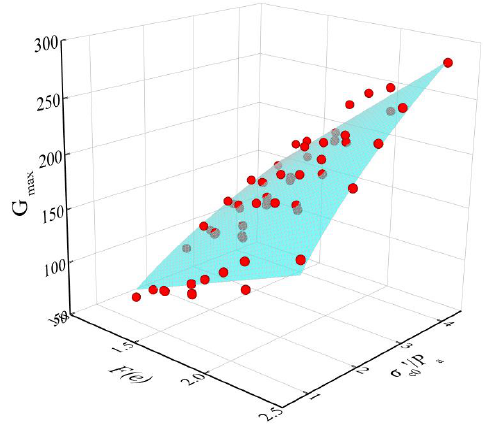
Figure Figure 8. The modified Hardin model for Nantong marine silty sand with different FC in G max - F ( e *)- c0  / P a space.